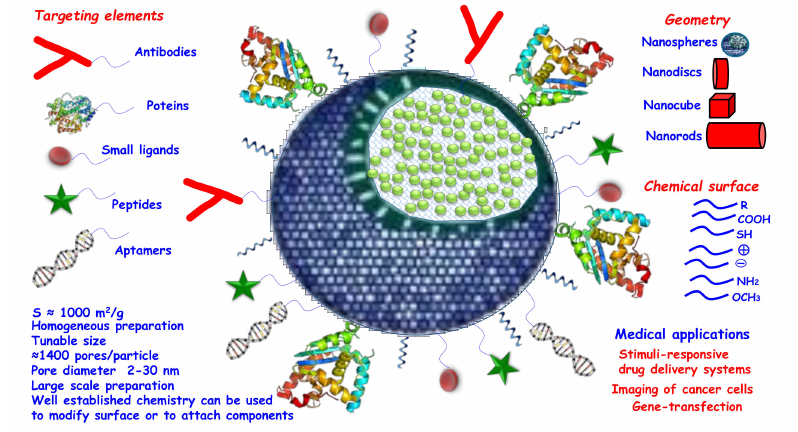
Figure 1. Schematic representation of characteristics of mesoporous silica nanoparticles (MSNs) for biomedical